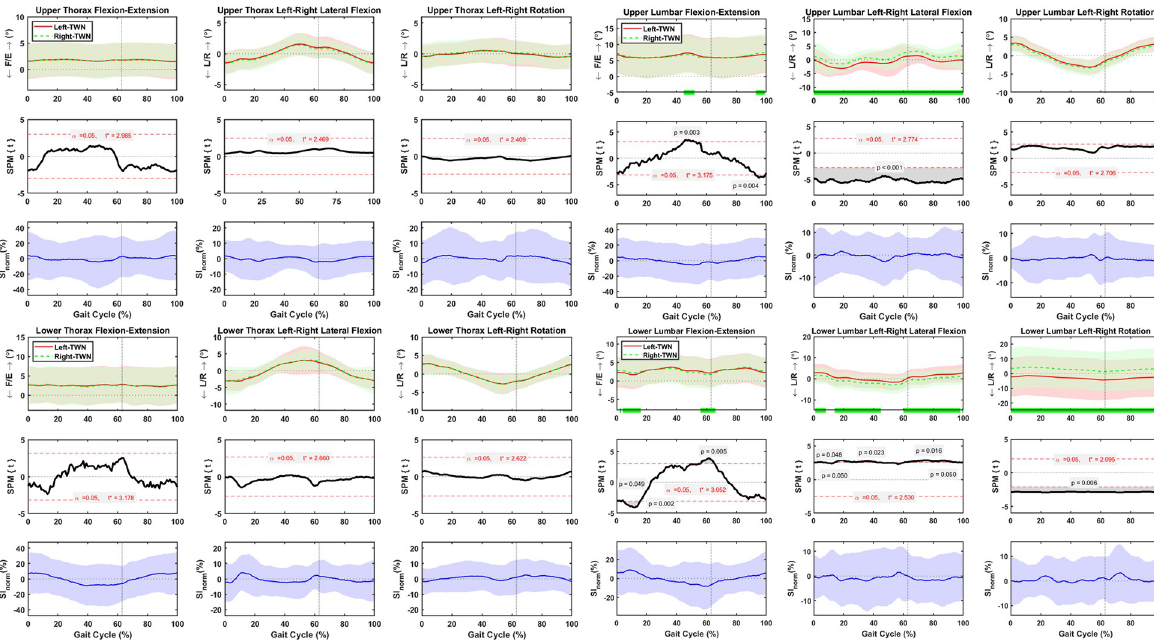
Fig 3. Average and standard deviation of upper thorax, lower thorax, upper lumbar, and lower lumbar flexion-extension (F/E), left-right (L/ R) lateral flexion, and (L/R) rotation, for left and right sides during one gait cycle of normal treadmill walking (TWN) in sixty healthy participants. Green bars on the horizontal axis and the scalar field SPM results with threshold t � depict where, in % cycle, left side angles were greater or lesser than right side angles. The normalized symmetry index (SI norm ) calculated during one gait cycle of TWN. Solid and dashed lines correspond to average left and right sides, as well as average SI norm , and shaded areas correspond to standard deviation. Black dotted vertical lines denote